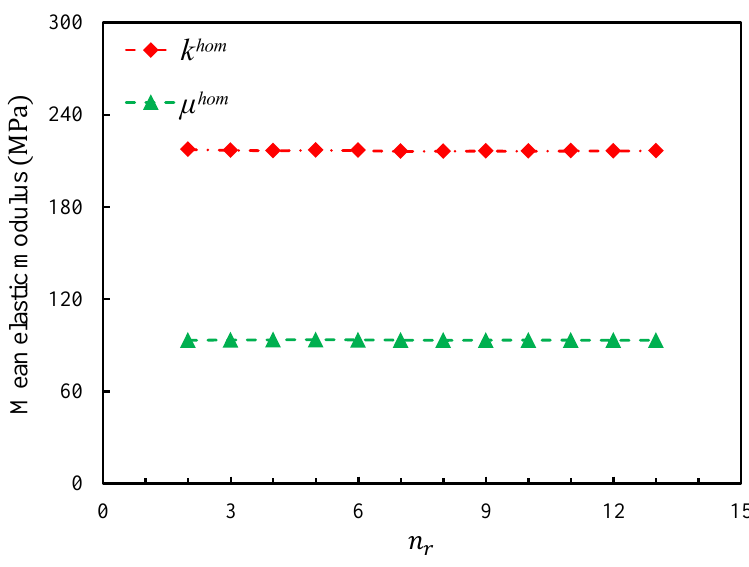
Figure 9. Evolutions of k hom and µ hom as a function of the number of realizations for Set A.